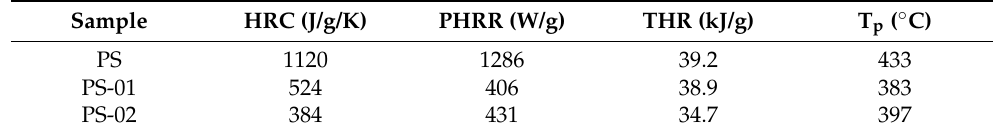
Table 4. Characteristic parameters in MCC tests.